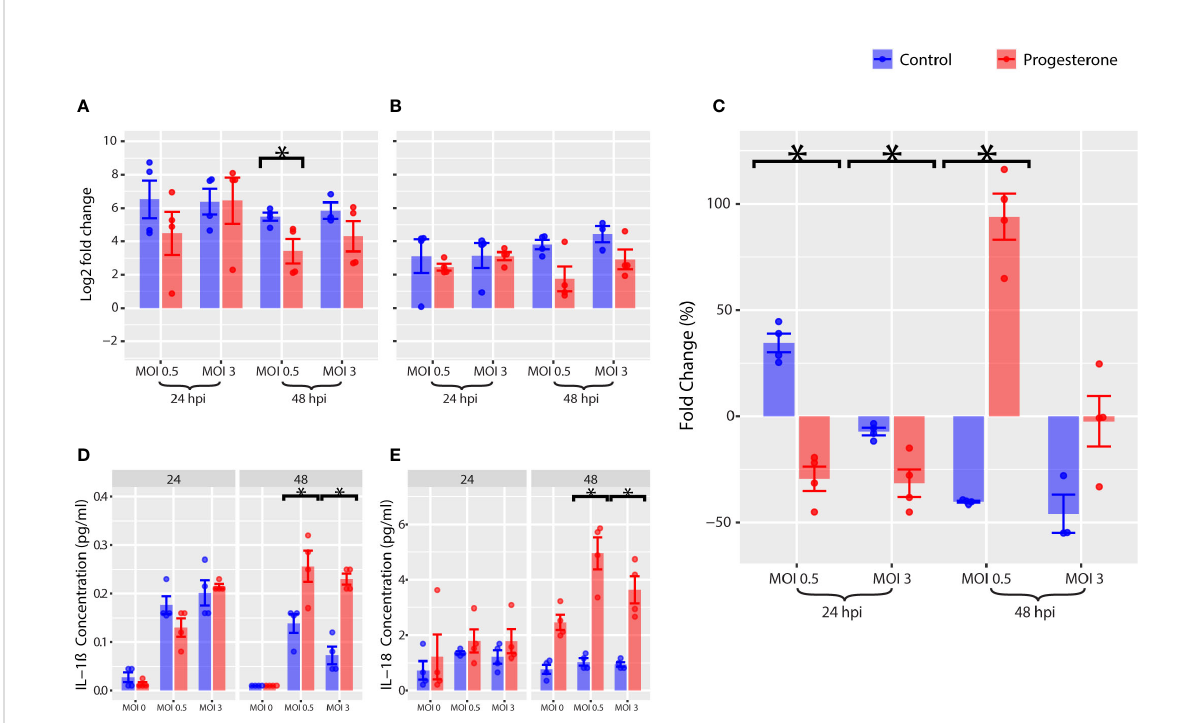
FIGURE 6 NLRP3 in fl ammasome in ACH-3P, a placental cell line. Various markers of the NLRP3 in fl ammasome pathway were measured in ACH-3P. Gene expression of IL1B (A) and NLRP3 (B) were measured by RT-qPCR. As a marker for NLRP3 in fl ammasome activation, caspase-1 activity was measured (C) . The change in concentration of IL-1 b (D) and IL-18 (E) over time was measured by Luminex. *p-value was less than 0.05, as determined by the statistical analysis detailed in the Methods